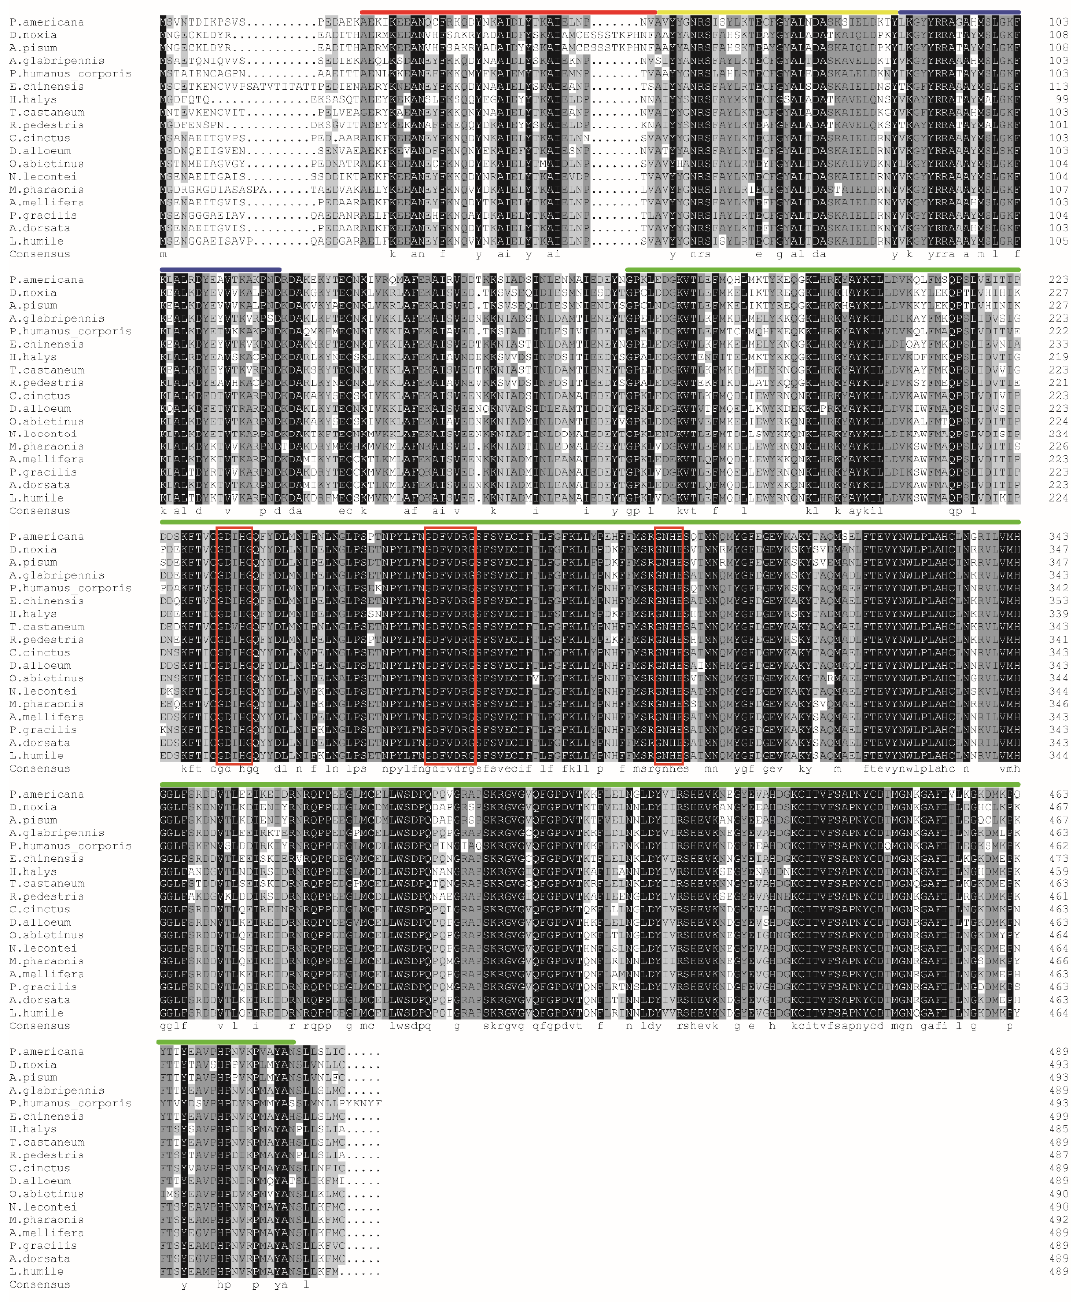
Figure 2. Multiple alignments of the deduced amino acid sequences of PP5 from P. americana and with other insect species (( D. noxia , GenBank: XP_015379688.1; A. pisum , GenBank: XP_008181438.1; A. glabripennis , XP_018576896.1; P. humanus corporis , XP_002425763.1; E. chinensis , AHF45878.1, H. halys XP_014290865.1, T. castaneum XP_971407.1, R. pedestris BAN20786.1; C. cinctus , XP_015610020.1; D. alloeum , XP_015119779.1; O. abietinus , XP_012286908.1; N. lecontei , XP_015517121.1; M. pharaonic , XP_012542571.1; A. mellifera , XP_006567817.1; P. gracilis , XP_020284073.1; A. dorsata , XP_006613765.1; L. humile , XP_012231410.1). The TPR domains are shown in red, yellow, and blue lines. The predicted catalytic domain of PaPP5 (PP5c) is indicated by a green line. The three conserved motifs (-GDXHG-, -GDXVDRG-, and -GNHE-) are presented in a red horizontal